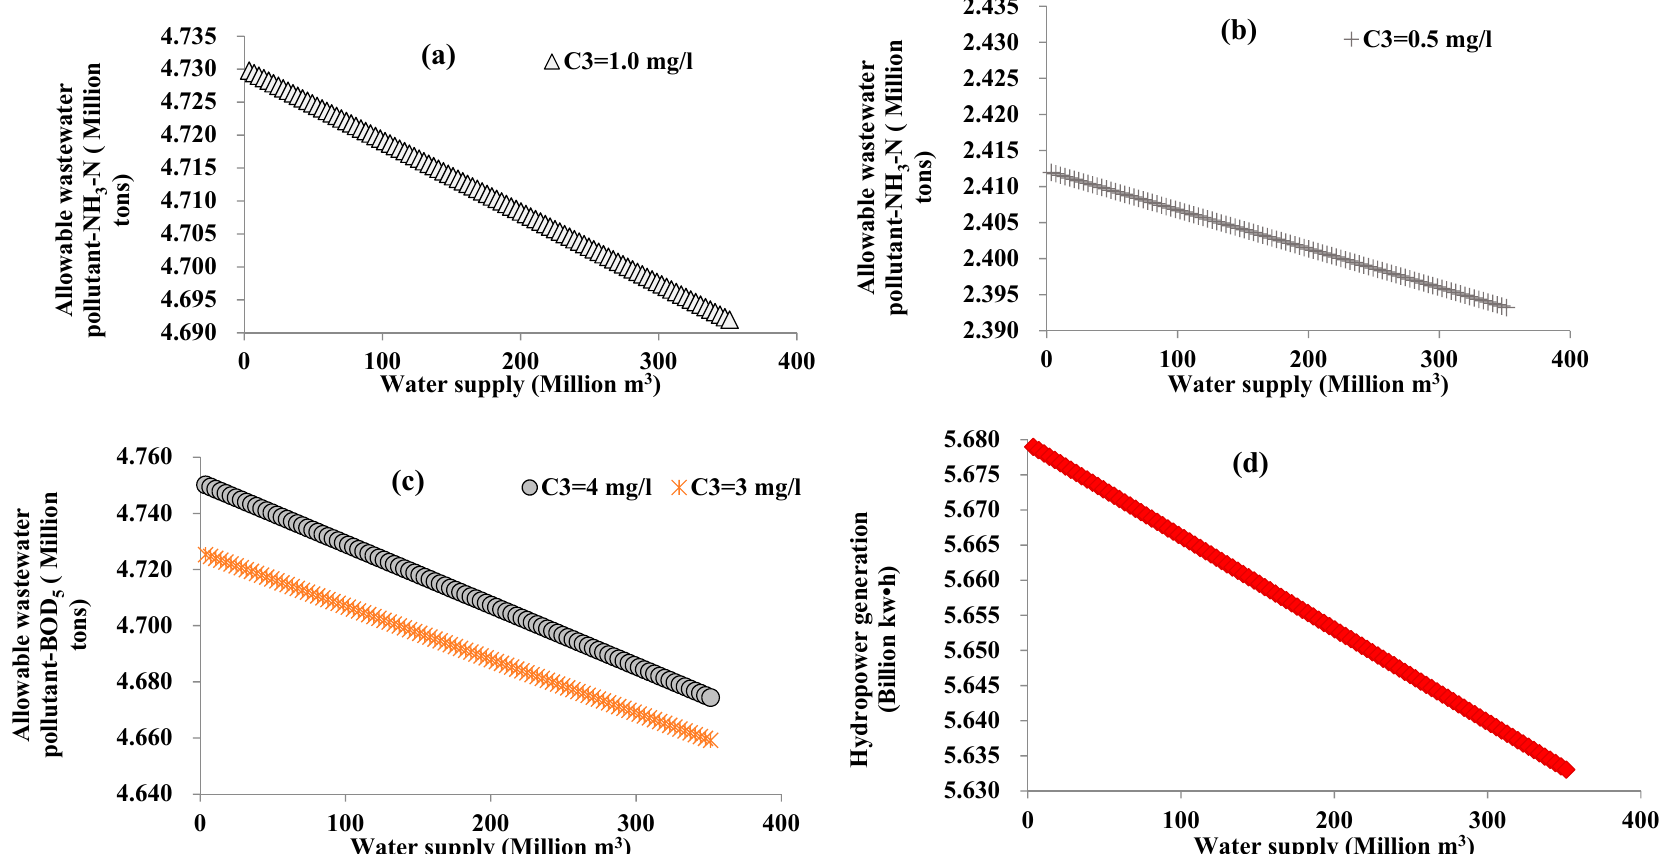
Figure 5. The relationships between water supply and allowable wastewater pollutant under the inflow frequency level p = 99%: ( a ) for NH3-N with the Class III ( C 3 = 1.0 mg / L) water quality protection target, ( b ) for NH3-N with the Class I ( C 3 = 0.5 mg / L)water quality protection target, ( c ) for BOD5 with the Class III ( C 3 = 4.0 mg / L) and I ( C 3 = 3.0 mg / L) water quality protection target, and ( d ) for relationship between water supply and hydropower generation.